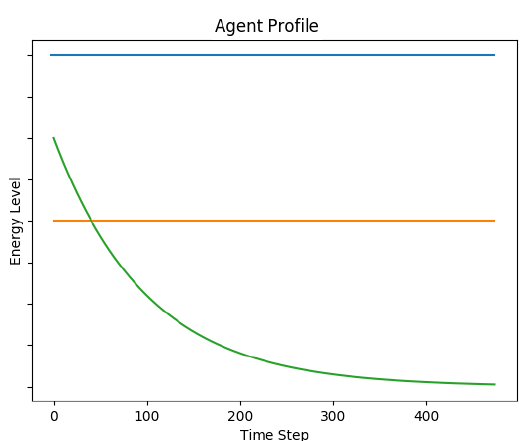
Figure9. TypicalbehaviorofthevariablecontrolledbytheagentA3CWEG. The green line indicates the variable evolution. The orange and blue lines in- dicate the variable’s target range ( min,max ) . The variable’s behavior was the same consolidated in this figure, regardless of the target range selected.